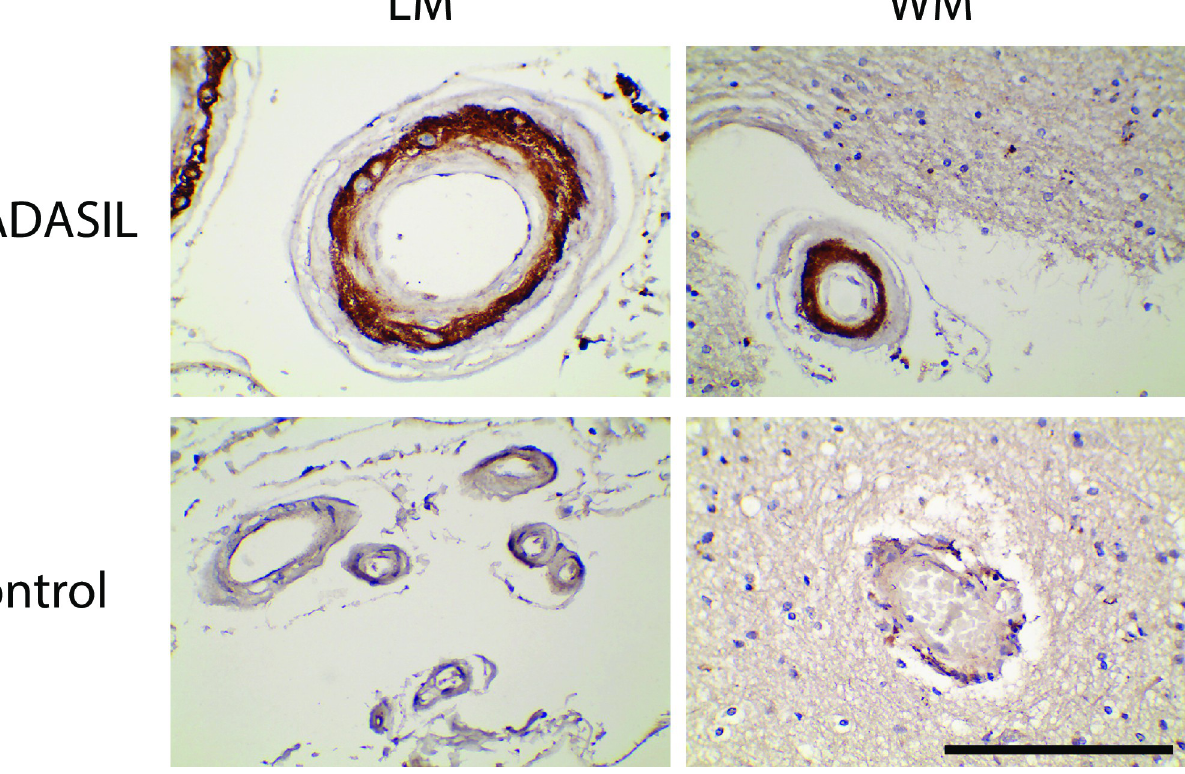
Fig 1. NOTCH3 protein localization in CADASIL and control arteries. Localization of NOTCH3 fragmentation products was performed in CADASIL (top row) and non-CADASIL frontal cortex by immunohistochemistry with UMI-F, which recognizes the neo-epitope generated by fragmentation of NOTCH3 at the junction between EGF-like repeats 1 and 2. The left panels show leptomeningeal arteries (LM) and the right panels show white matter arteries (WM). Arteries from both regions demonstrate medial staining corresponding to the vascular smooth muscle layer of arteries with deficiency in the intimal and adventitial layers. Scale bar shows 100